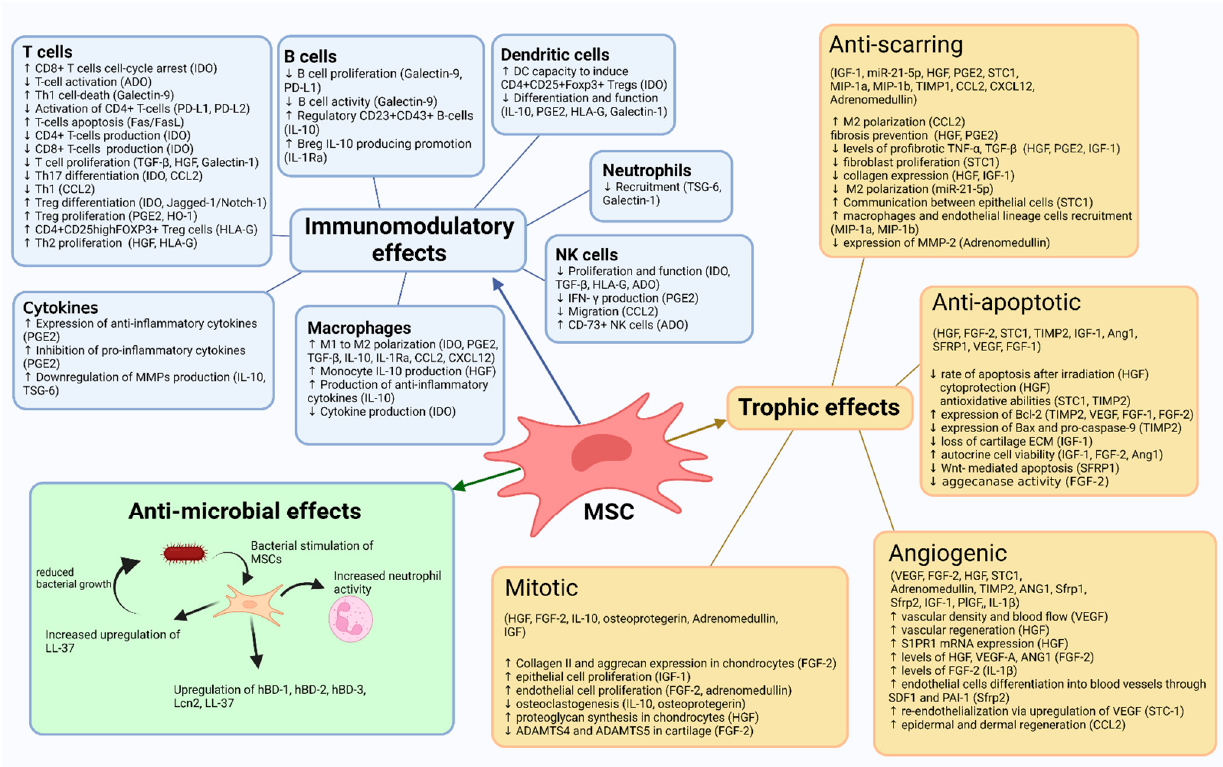
Figure 1. A summary of mesenchymal stem cell (MSC) effects. IDO—Indoleamine 2,3-dioxygenase;